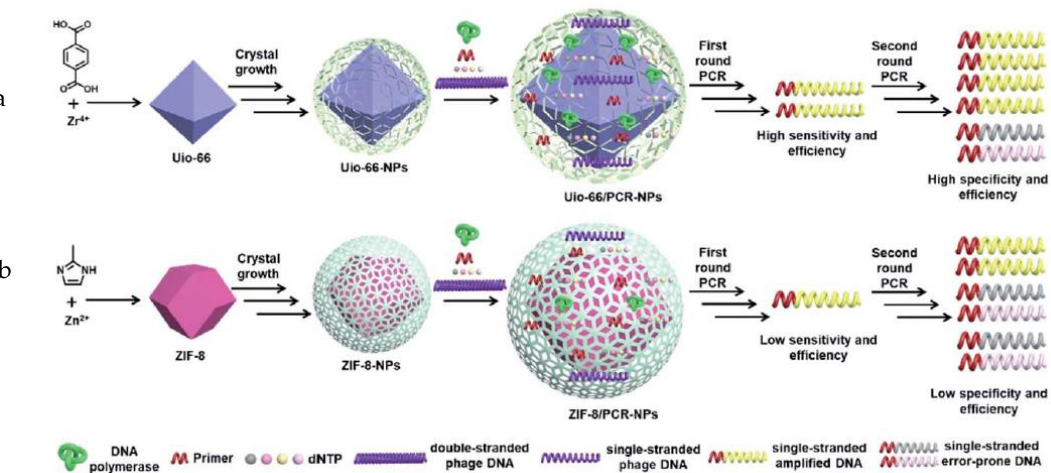
Figure 3. Mechanism speculation of improved PCR by UiO-66 and ZIF-8. M, DL2000 marker: ( a ) PCR was carried out with different Taq polymerases and 0.1 mg L1 l-DNA. Left lanes 1–4, conventional PCR; middle lanes 1–4, UiO-66-assisted PCR; right lane 1–7, ZIF-8-assisted PCR. The final concentrations of Taq polymerase from lane 1 to 4 are 0.25 U, 0.5 U, 1 U, and 2 U per 10 mL, respectively. In (A and C), the white frame indicates the location of the target band in all lanes. ( b ) The possible interaction among templates, Taq polymerase, and UiO-66 (or ZIF-8) during PCR. Reprinted with permission from ref. [32]. Copyright 2020, RSC.